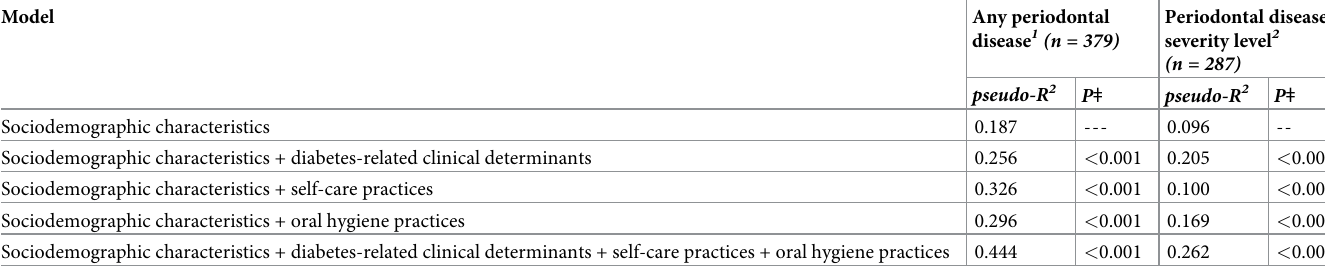
Table 3. Hierarchical regression models of any periodontal disease and its severity among type 2 diabetics. Model